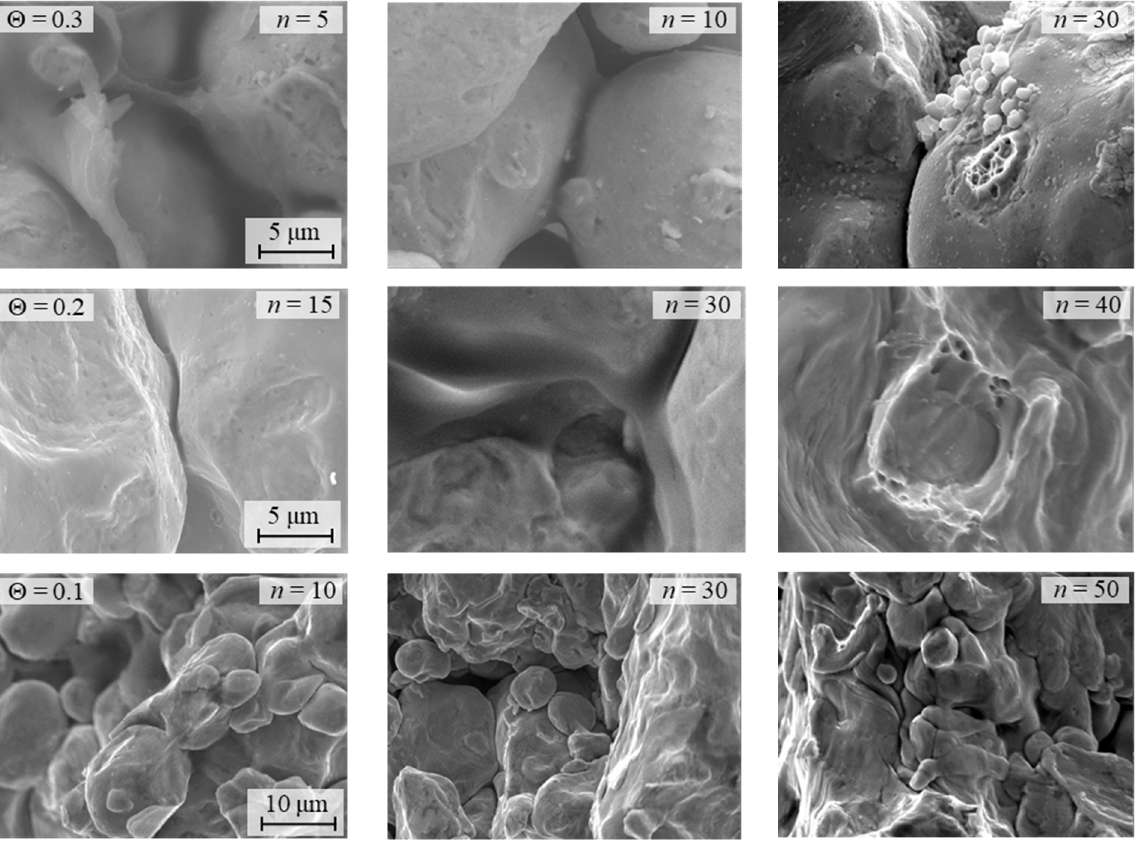
Figure 6. Fracture surface of the specimens with initial porosity of 0.3, 0.2, and 0.1 after the number of discharges indicated at each image.